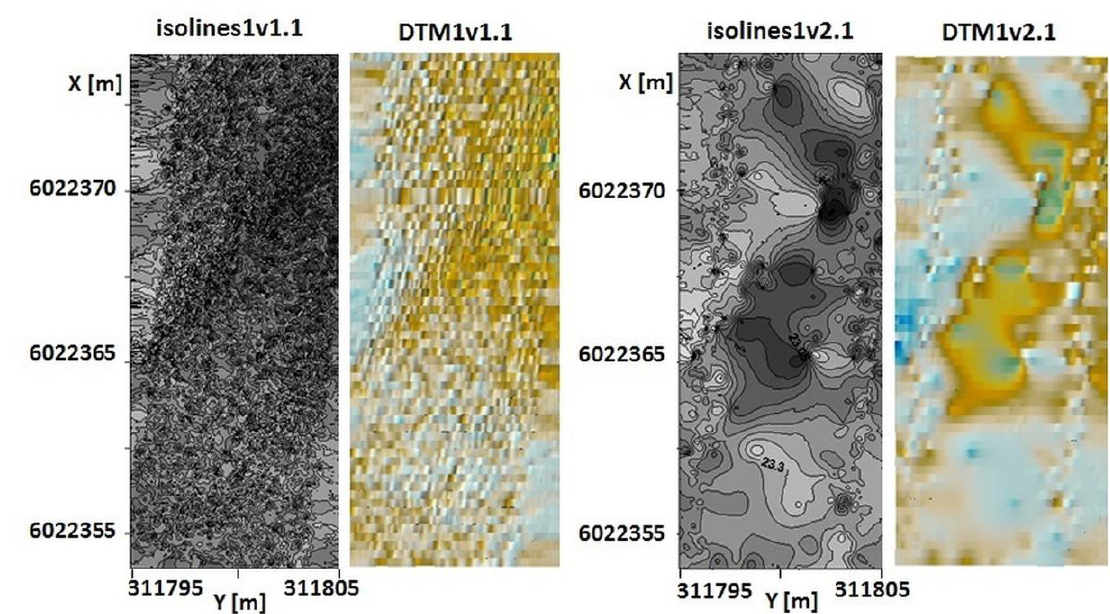
Figure 9. Isolines1v1.1 and digital terrain model (DTM)1v1.1, and isolines1v2.1 and DTM1v2.1 generated for strip 1 (p 1 ) by methodologies v1.1 and v2.1, respectively.